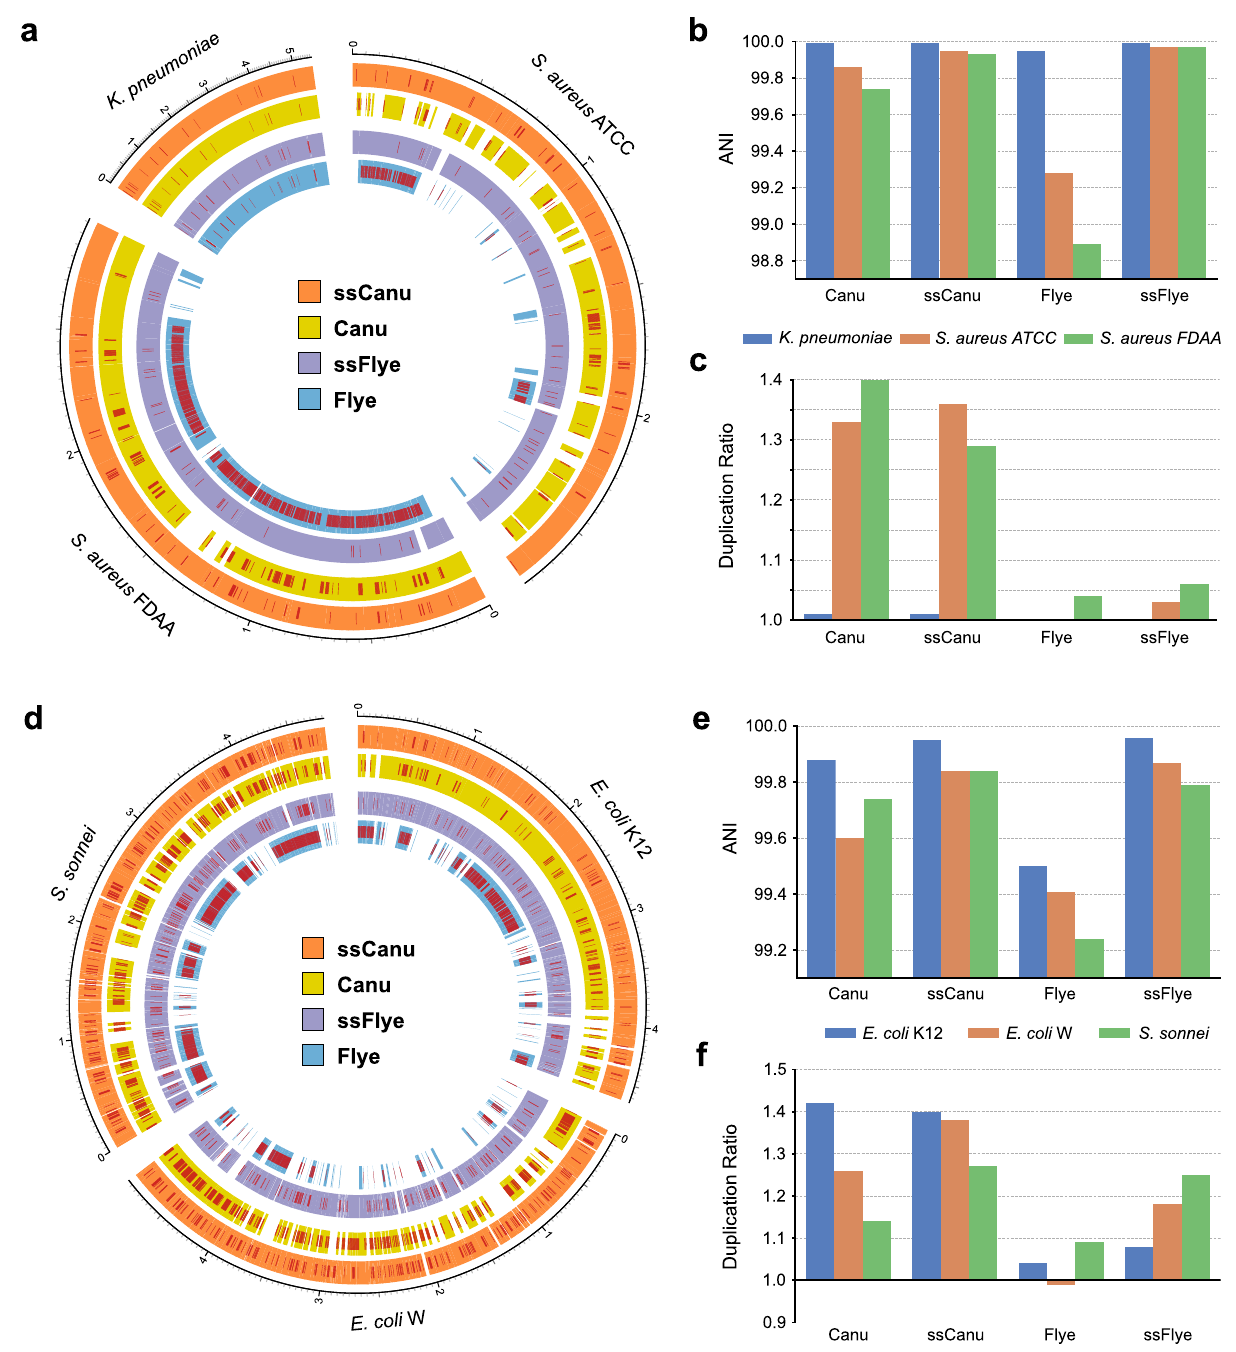
Fig. 3 Mock9 dataset assembly statistics. a Circos 58 graph depicting reference coverage and SNV-rich regions of the strain-oblivious assemblies (Flye and Canu) and their strain-separated counterparts obtained with Strainberry (ssFlye and ssCanu, respectively) compared to the reference sequences of K. pneumoniae and the two S. aureus strains. The external graduated scales represent the genomic positions of the corresponding reference genomes. On the right-hand side, b the average nucleotide identity and c the duplication ratio of each assembly are reported. The ssFlye and ssCanu assemblies were obtained as a result of a Strainberry separation of the Flye and Canu assemblies, respectively. d Circos graph depicting reference coverage and SNV-rich regions of the strain-oblivious assemblies (Flye and Canu) and the strain-separated ones (ssFlye and ssCanu) with respect to the reference sequences of S. sonnei and the two E. coli strains. On the right-hand side, e the average nucleotide identity and f the duplication ratio of each assembly are